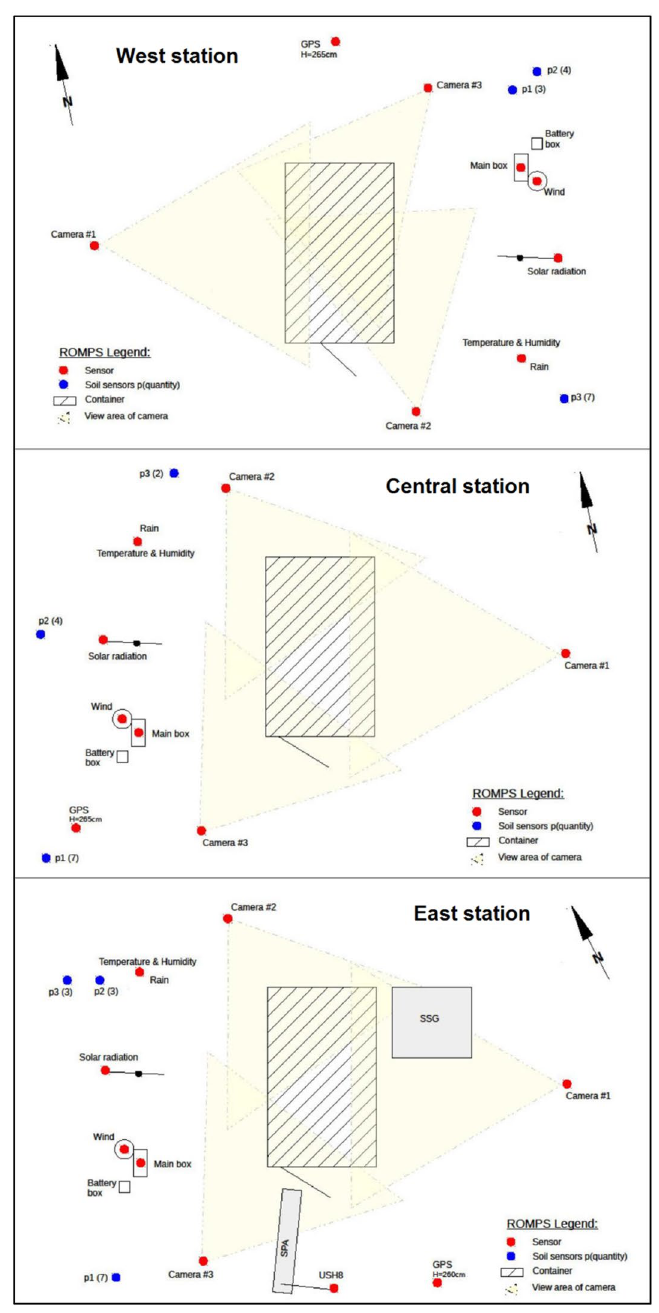
Fig. 11 Top view sketches of the hydrometeorological sensors (ROMPS) for the three gravity stations at Þeistareykir; bottom image (east station) includes positions of snow scale (SSG) and snow pack analyser